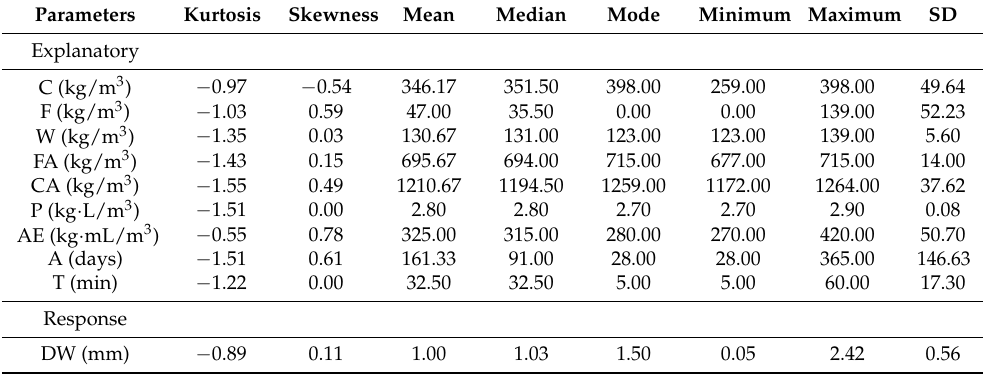
Table 4. Statistic of response and explanatory